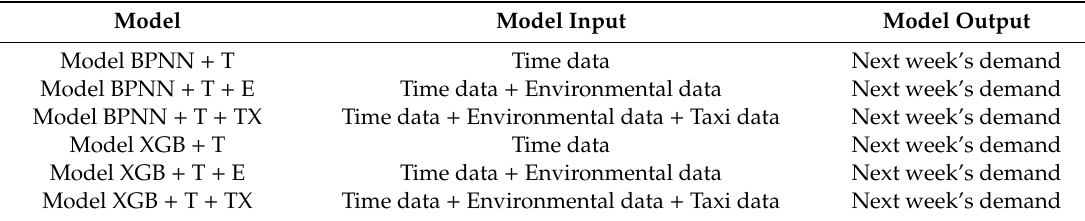
Figure 4. The demand for taxi and online taxi-hailing in Bell Tower area.